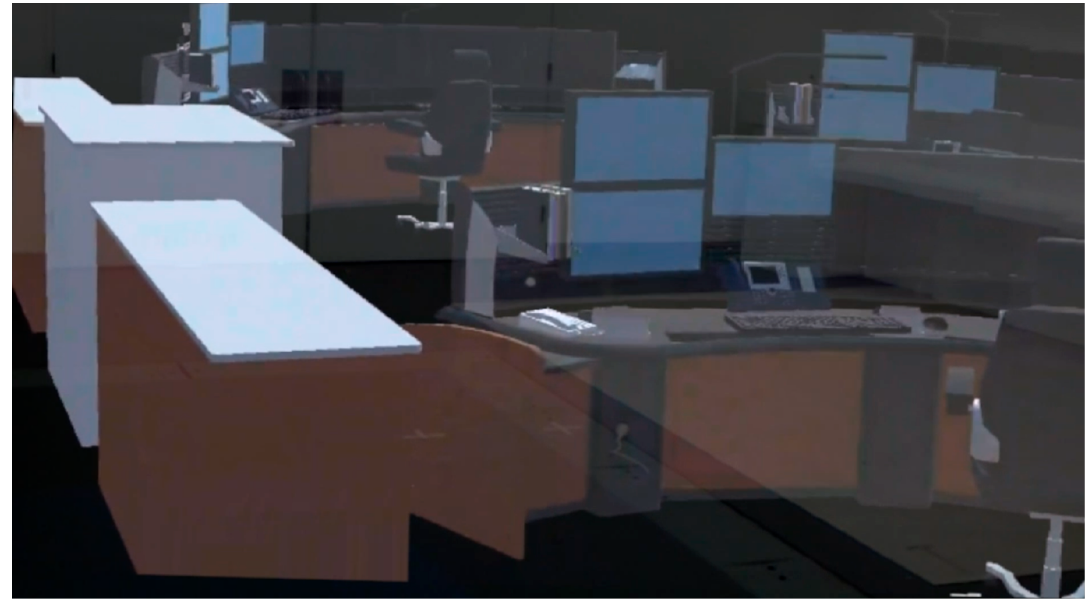
Figure 2. Three desks and three furniture cabinets shown in AR on a Microsoft Hololens 1. Even a small number of objects in the HMD field-of-view (FOV) quickly obfuscates the real world, even when the room behind is empty.